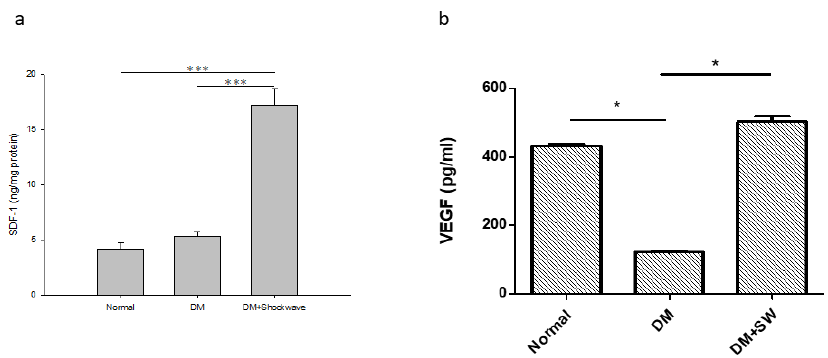
Figure 4. Low-energy SW significantly enhanced tissue repair and angiogenesis. ( a ) Enzyme-linked immunosorbent assay (ELISA) analysis pancreatic tissue SDF-1 indicating tissue repair; ( b ) ELISA analysis pancreatic tissue VEGF indicating angiogenesis. *** p < 0.001, * p < 0.05, ( n = 6–10). 2.5. Low-Energy SW Alleviated Oxidative Stress and Cell Apoptosis Oxidative stress can induce pancreatic beta cells apoptosis [4]. The compound 8- hydroxy- 2’- deoxyguanosine (8-OHdG) is a critical biomarker of oxidative stress [31]. Pancreatic